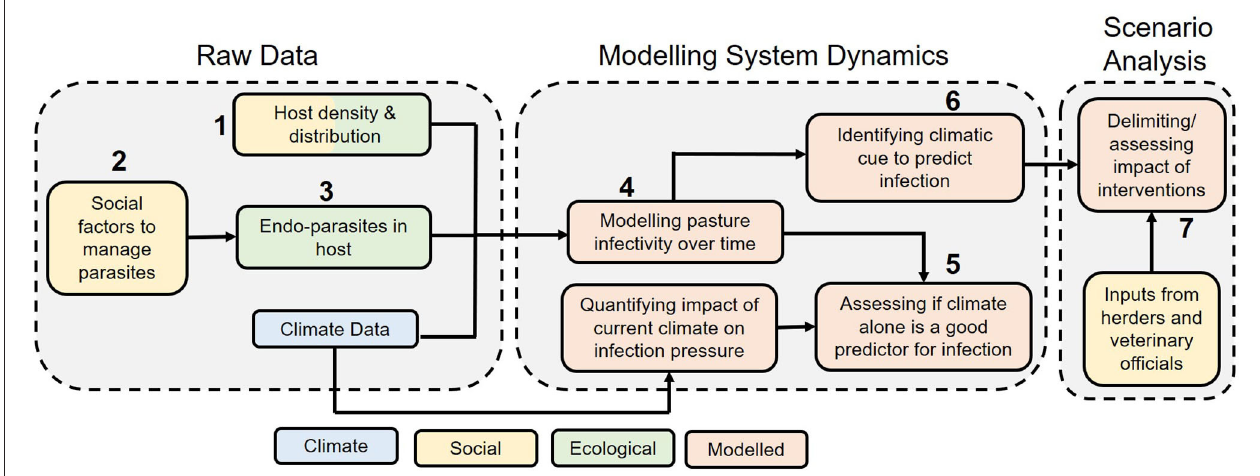
FIGURE 2 | A schematic showcasing how the different forms of evidence combine to give an overall picture of the two-host (bharal, and sheep GIN system to inform control measures. The numbers are linked to numbers in Table 1 below.